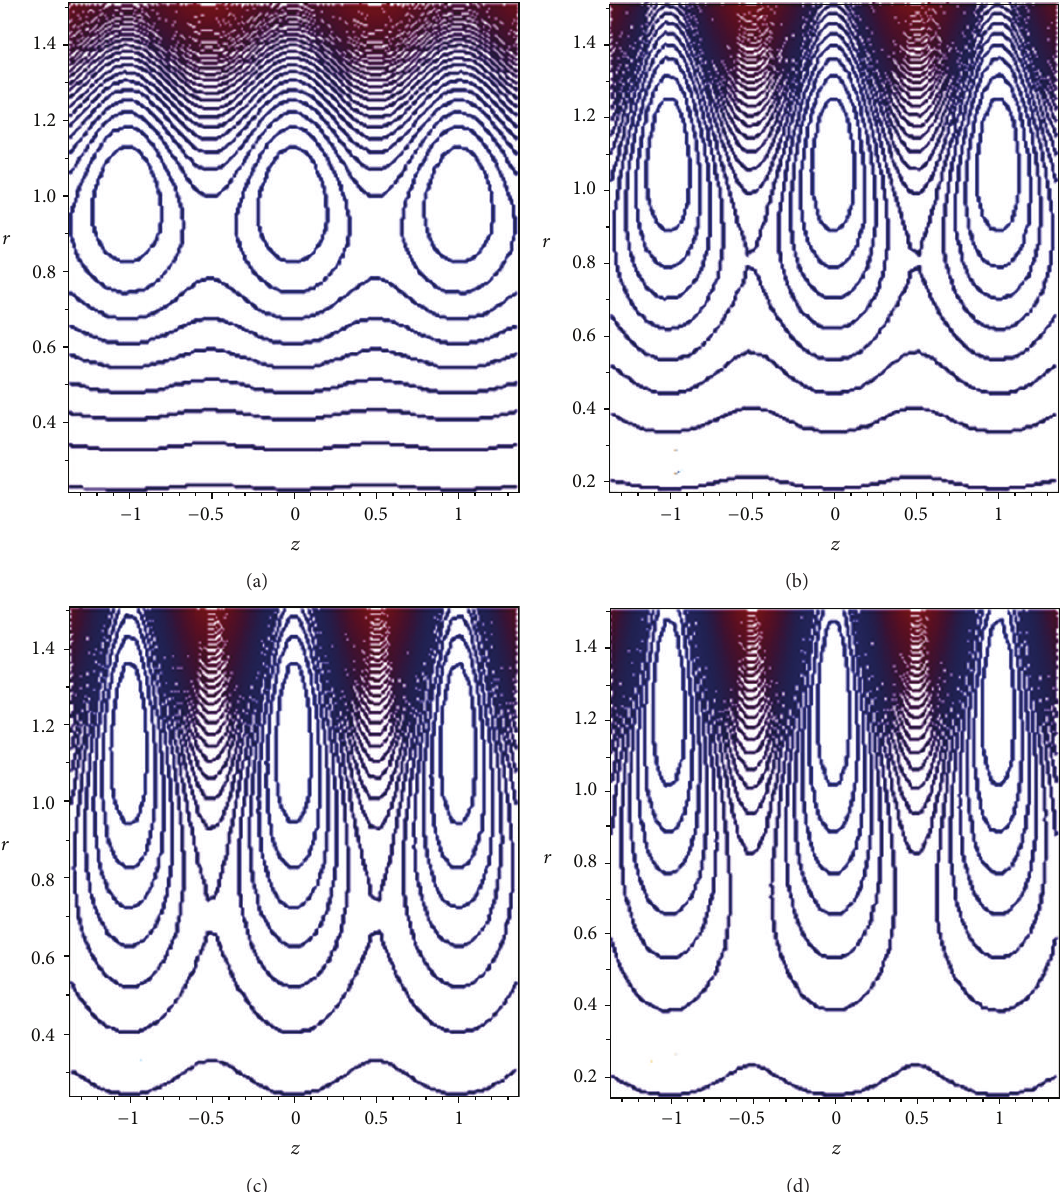
Figure 11: Streamlines for (a) 𝜀 = 0.05 , (b) 𝜀 = 0.15 , (c) 𝜀 = 0.25 , and (d) 𝜀 = 0.35 . The other parameters are 𝐻 𝑝 = 0.05 , 𝛼 = 0.4 , 𝛽 = 0.4 , and 𝑄 = 0.95